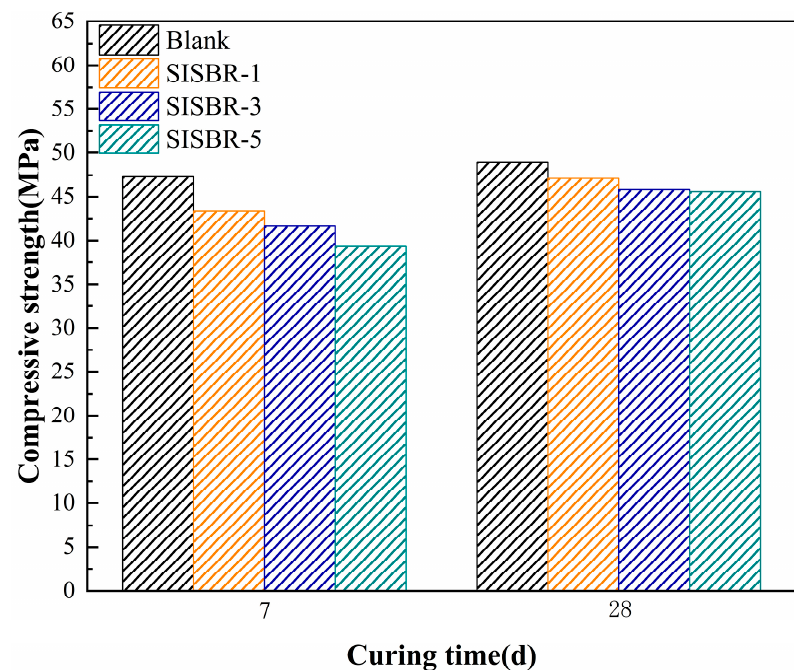
Figure 12. Compressive strength of hardened cement with